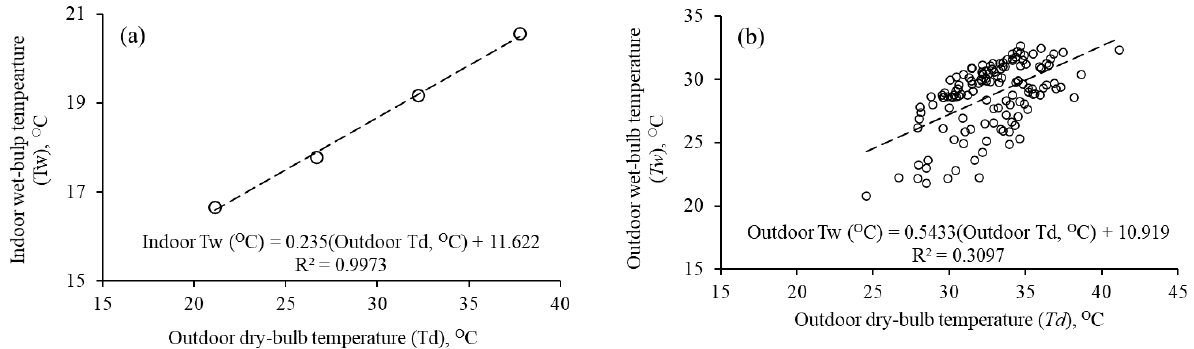
Figure 4. Relationships between ( a ) indoor wet-bulb and outdoor dry-bulb temperatures drawn from the data of the Engineering ToolBox [35], and ( b ) between the observed outdoor wet-bulb and outdoor dry-bulb temperatures.